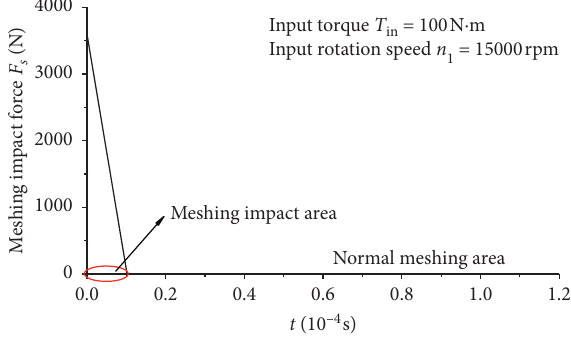
Figure 7: Meshing impact force